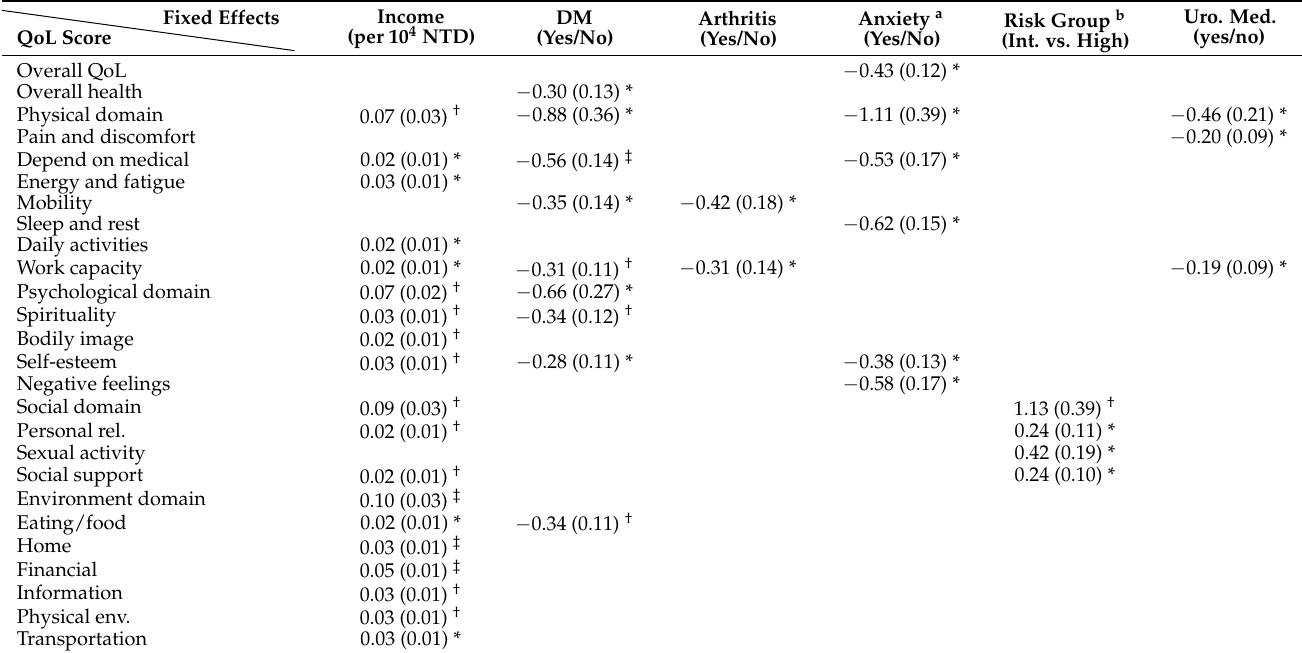
Table 3. Regression coefficients and standard errors (in parentheses) of fixed effects (or major determinants) for mixed effects models of domains and facet scores of the